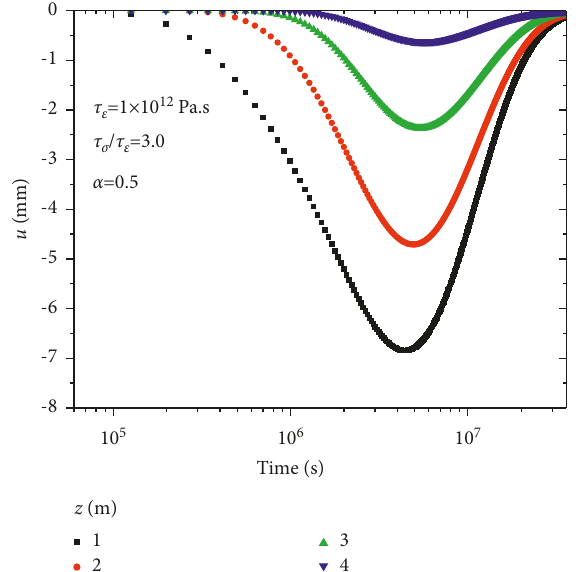
Figure 13: Influence of embedment depth on displacement when τ